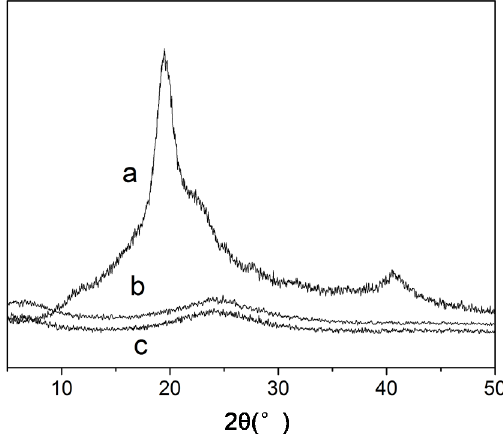
Figure 3. X-ray diffraction patterns of PVA/SiO 2 -TiO 2 hybrid fibers with different mass ratio. ( a ) is pure PVA fiber; ( b ) and ( c ) are the mass ratio of 1:5 and 1:3 between PVA and SiO 2 -TiO 2 ,